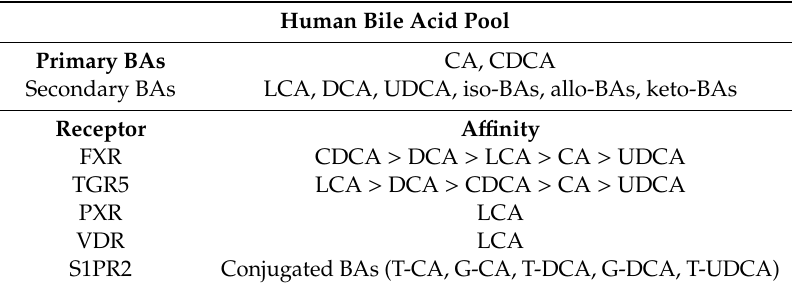
Table 1. The human bile acids and their